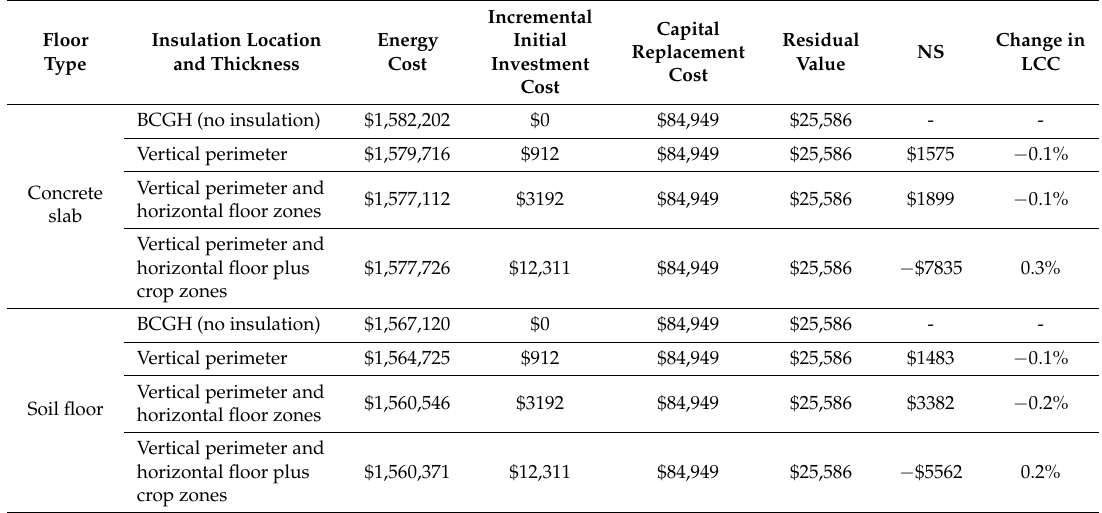
Table 3. Present-value costs, residual value, NS, and change in LCC for the greenhouse